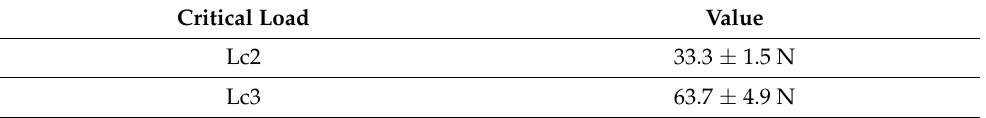
Table 3. Critical load values (Lc2 and Lc3) measured in the scratch